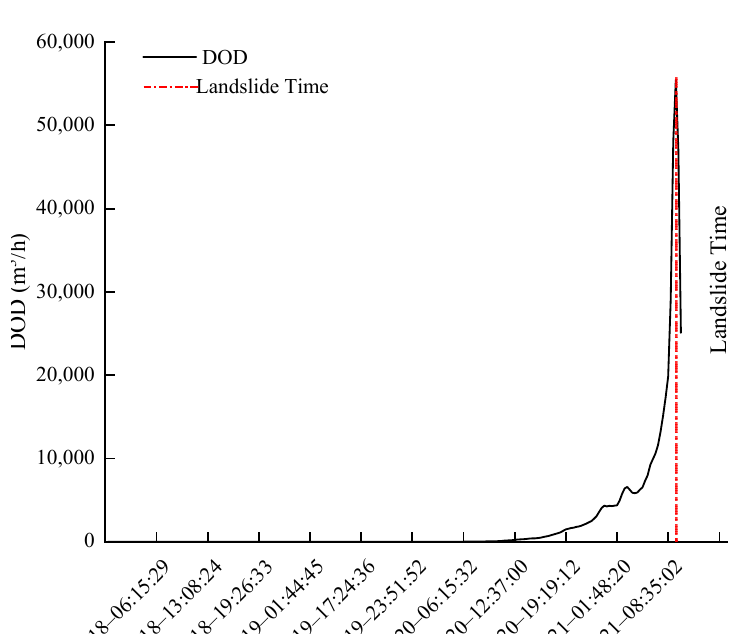
Figure 11. Coherence curve.